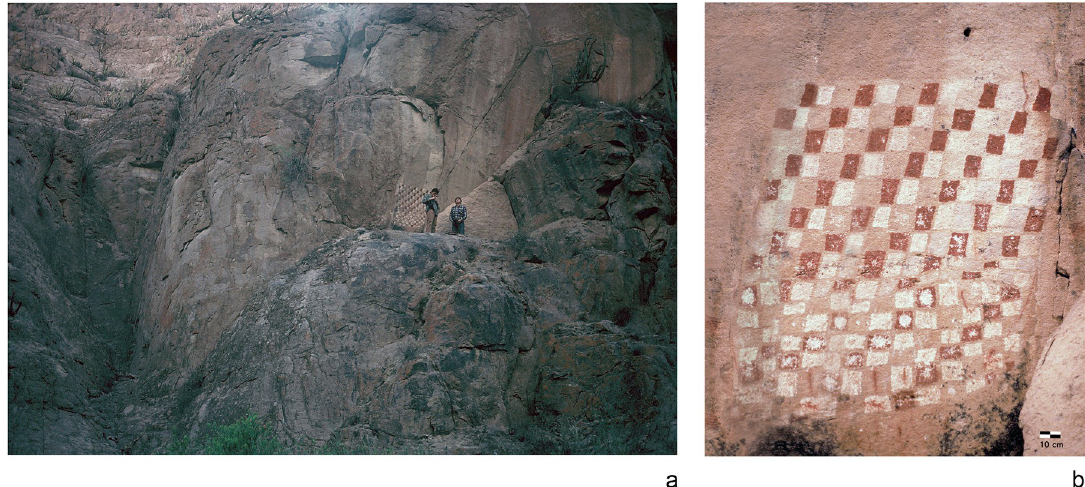
Fig 3. Rocky cave in the Molle Grande sector, Codpa Valley, upstream from the Chaca or Vitor canyon. (a) general view of the pictograph with red and white squares on the lower half of the steep valley wall; (b) closeup of the pictograph. (Photograph courtesy of Arthur Aufderheide†).